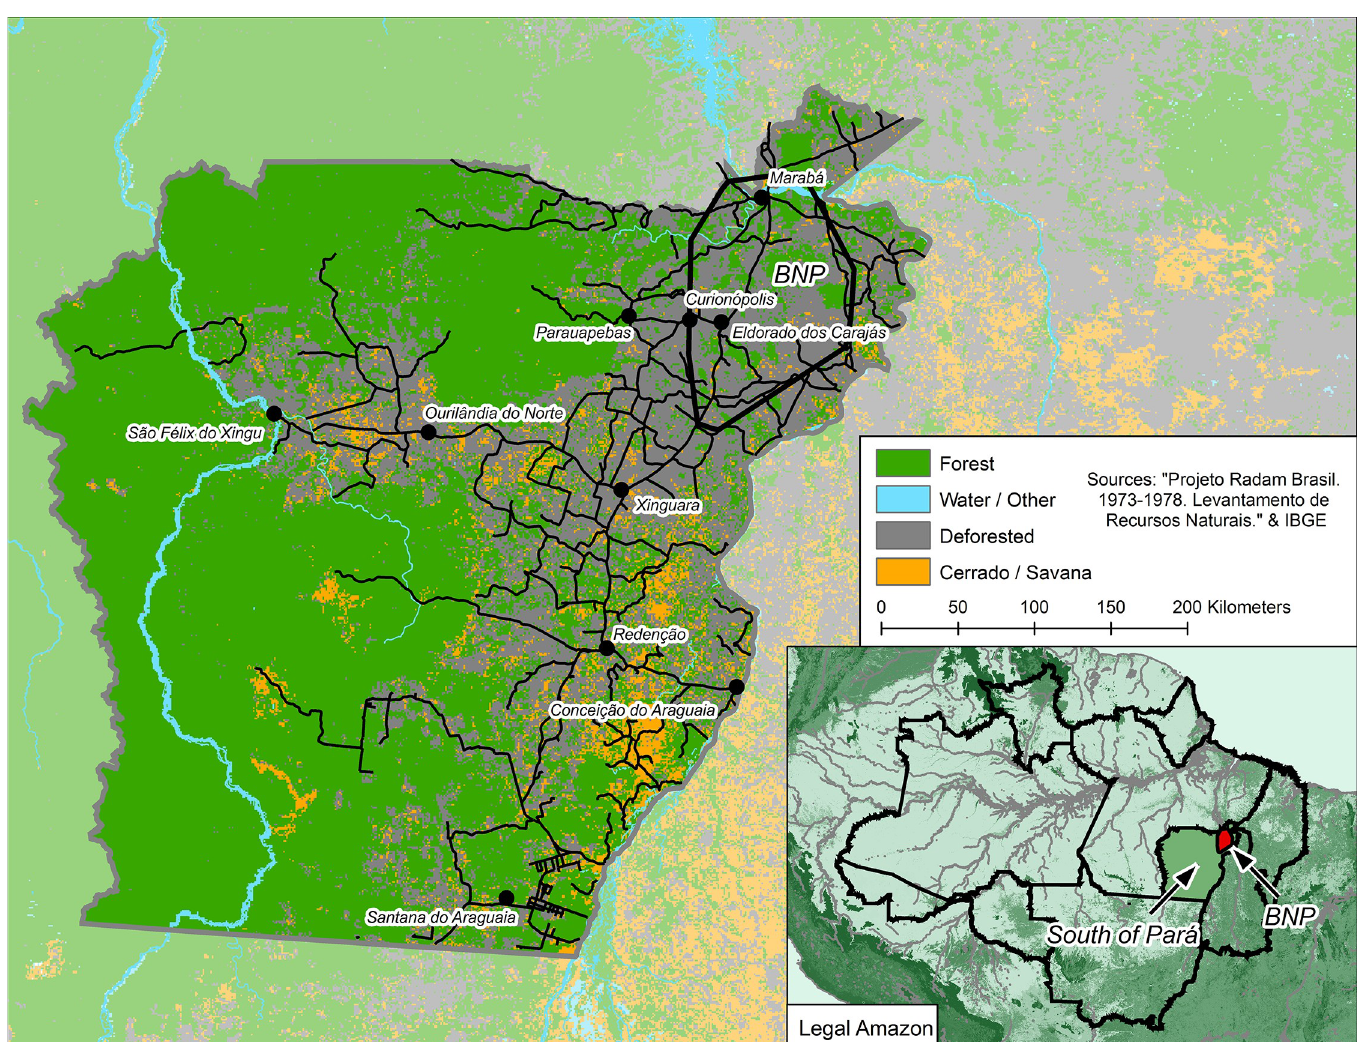
Fig 1. Dominant vegetation pre-1970 in Southeastern Para´, Brazil. The Brazil Nut Polygon is in the upper right (Northeast) corner of the region. Southeastern Para´ straddles the ecotone between closed-canopy forests of the Amazon and the Savanah environments of Brazil’s